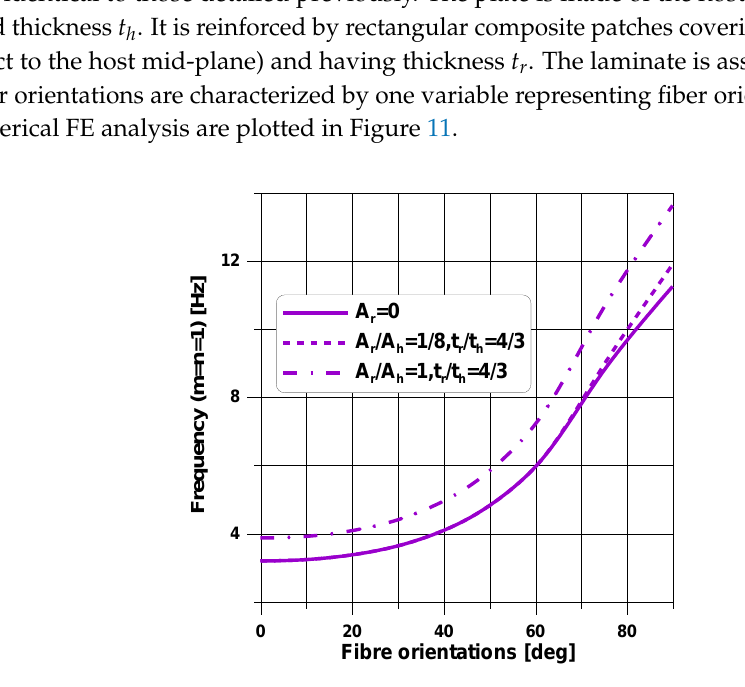
Figure 10. Contours of natural frequencies on the x , y plane for and symmetric laminates—free- clamped (FFFC) plates.